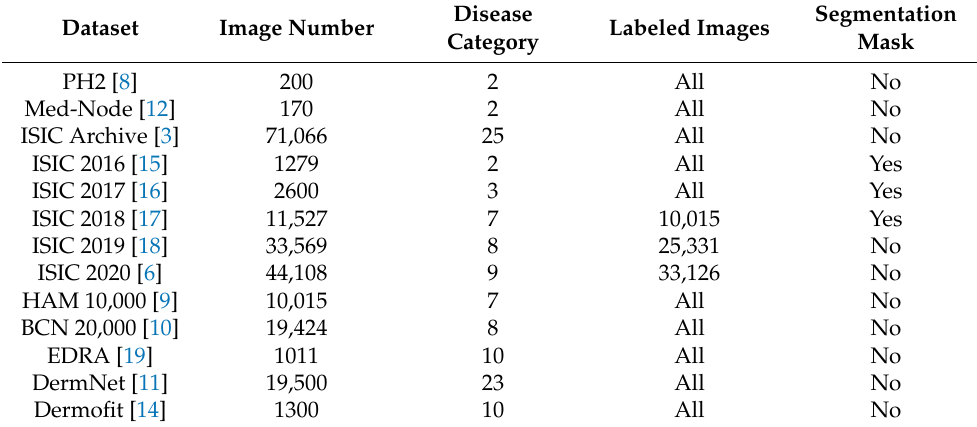
Table 1. Summary of publicly available skin lesion